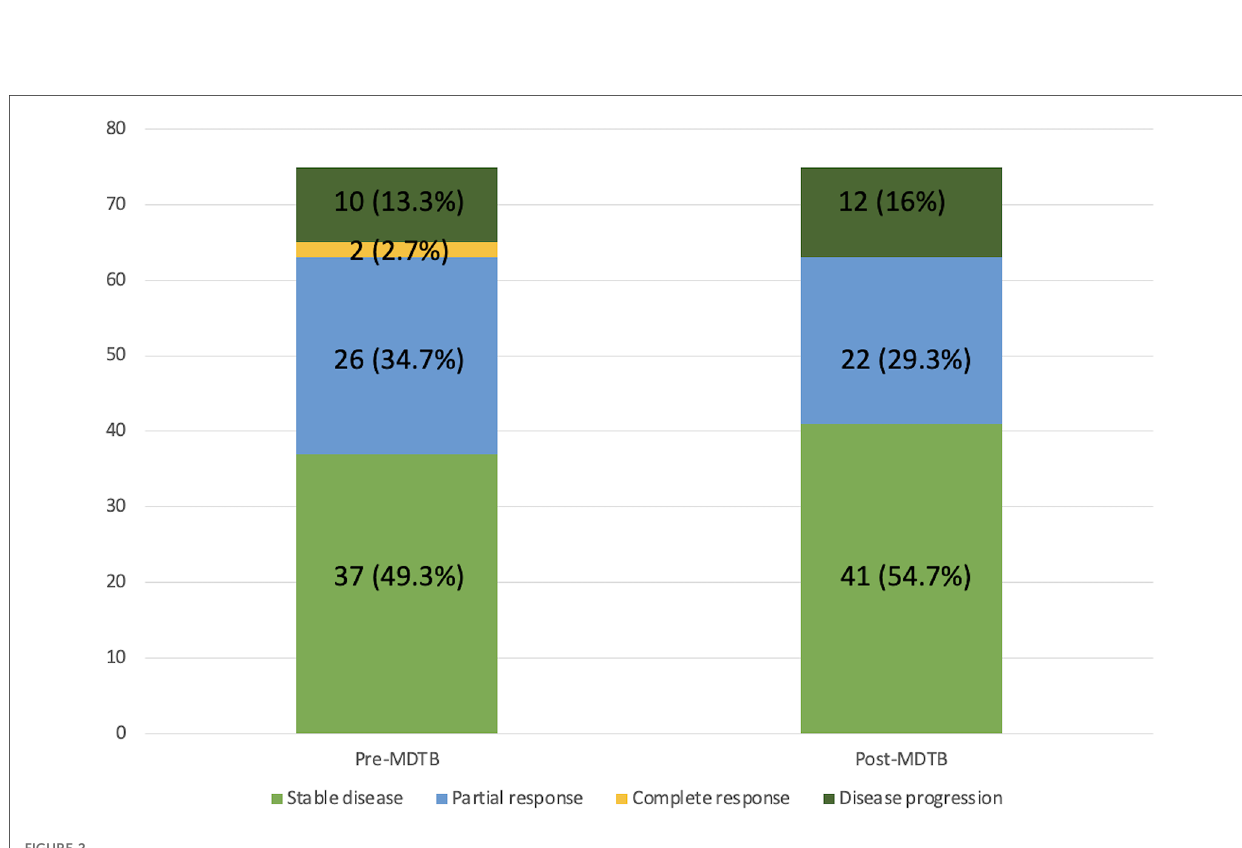
FIGURE 2 Tumor response assessment variation after MDTB